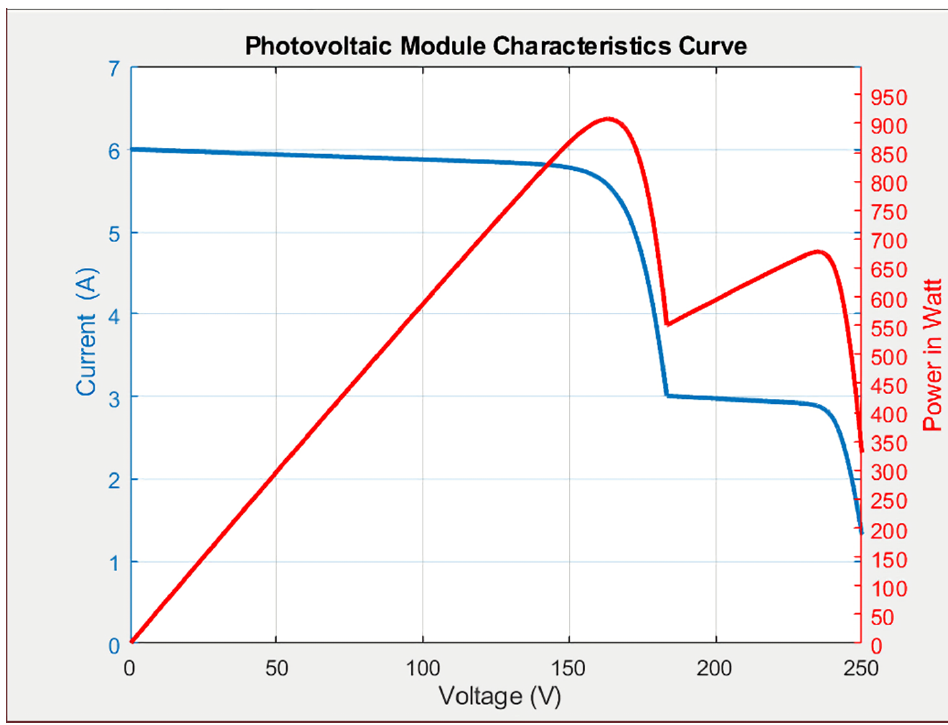
Figure 2. P–V and I–V characteristic curves of the photovoltaic module array with four series and one parallel structure and with one module under 50% shade.